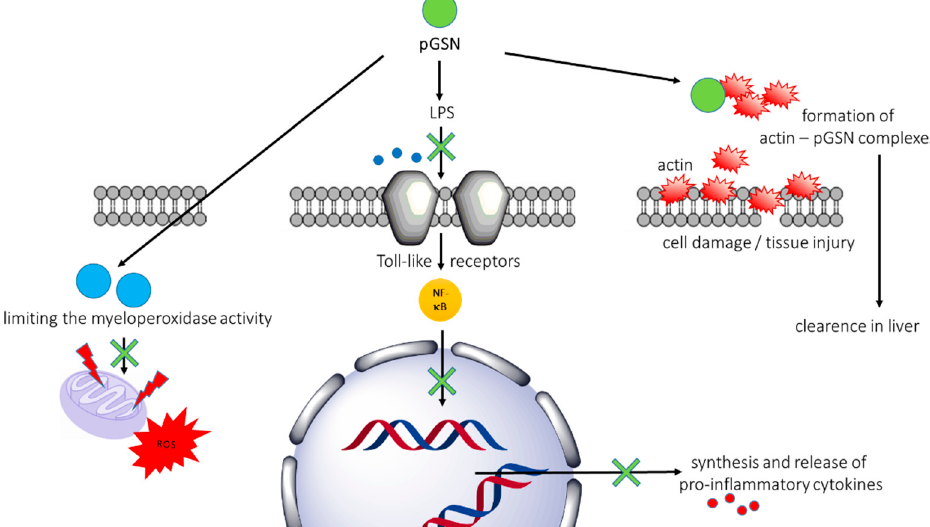
Figure 2. The protective role of gelsolin against oxidative stress, microbial-induced inflammatory states, and toxic effects of actin released from damaged cells and tissues.